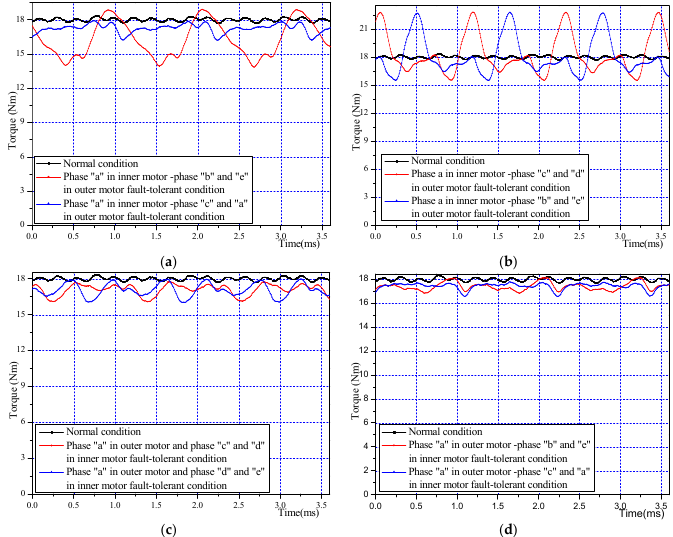
Figure 25. The electromagnetic torque obtained by FEA under double phase open circuit fault in one motor with single phase open circuit in another motor: ( a ) fault type I; ( b ) fault type II; ( c ) fault type III; ( d ) fault type IV. Table 12. The details of electromagnetic torque under double phase open circuit fault in one side of motor with single phase open circuit in another side of the motor. Motor Fault Types *